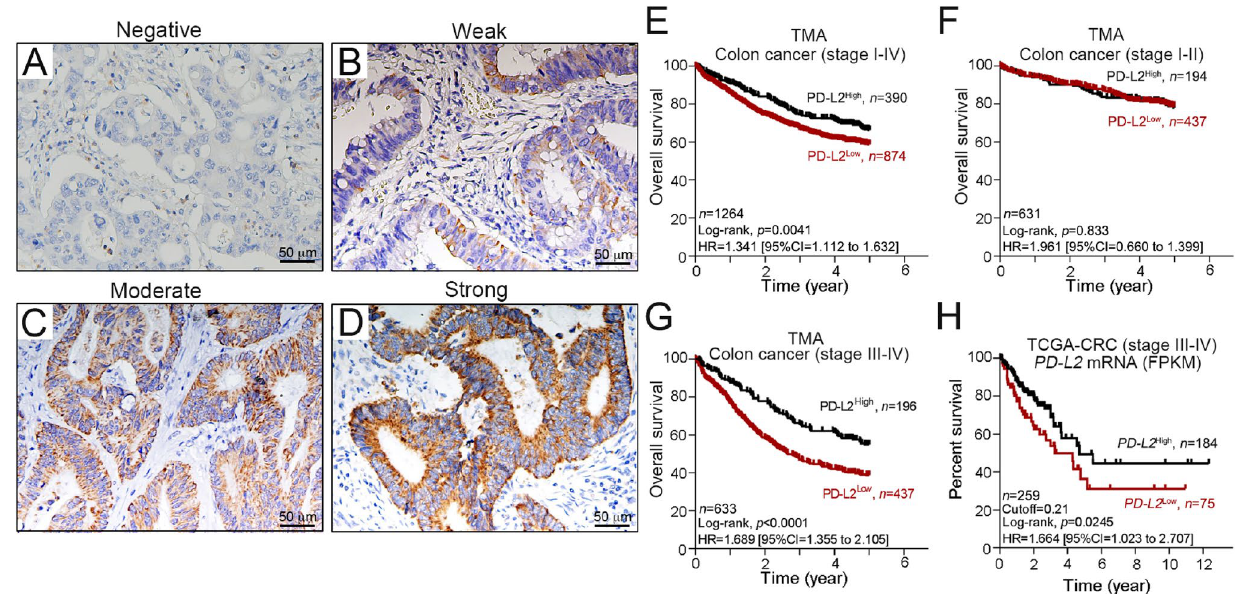
Figure 1. Expression patterns of tumor PD-L2 within the tumor microenvironment are associated with survival outcome in stage III-IV colon carcinoma. ( A ) Negative tumor PD-L2 immunohistochemical staining within